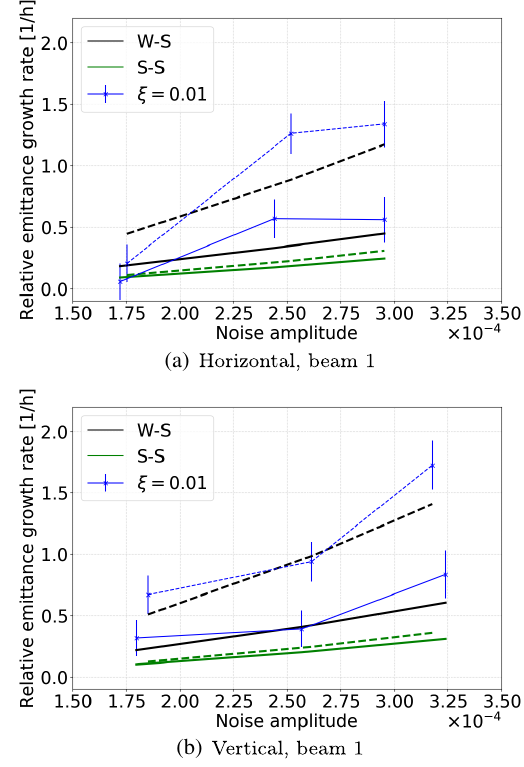
FIG. 8. Equivalent of the plots shown in Fig. 7 for high brightness bunches featuring a beam-beam tune shift twice as high (red